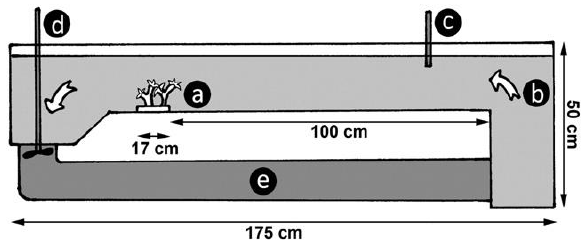
Fig. 1. Scale diagram of recirculation Plexiglas flume setup adopted from Purser et al. (2010). (a) test section with coral branches in plastic mount (depth 8cm), (b) direction of circulation, (c) food delivery point, (d) motor, (e) opaque plastic return